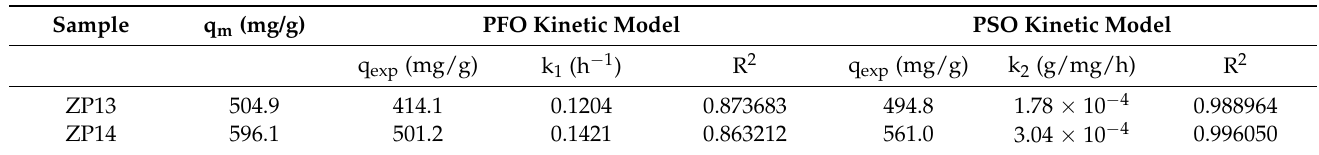
Figure 6. Effect of shaking time ( a ) and PFO ( b ) and PSO ( c ) kinetic models for adsorption of MB onto ZP13 and ZP14. Adsorption isotherms ( d ) and linear Langmuir plots ( e ) for adsorption of MB onto all the prepared solid adsorbents. Table 1. Pseudo-first-order and pseudo-second-order kinetic model parameters for MB adsorption Table 2. Langmuir adsorption parameters for MB adsorption onto prepared solid adsorbents. onto ZP13 and